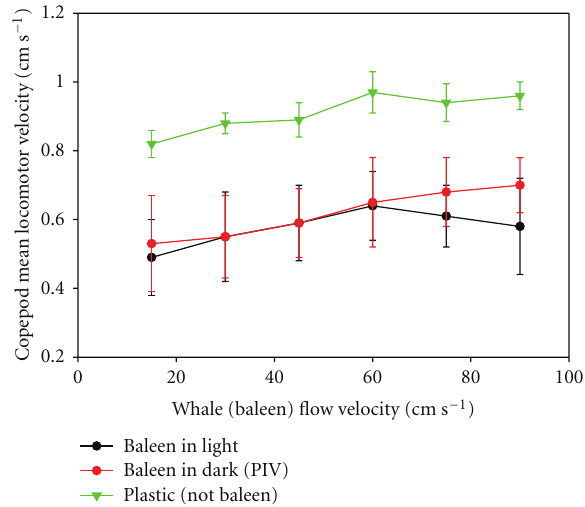
Figure 3: Copepod ( Calanus ) locomotor velocity (mean, N = 35; error bars = 1 SD) in “still” tank, measured at 10 cm distance from closest point of moving baleen, in light and dark (22 degrees